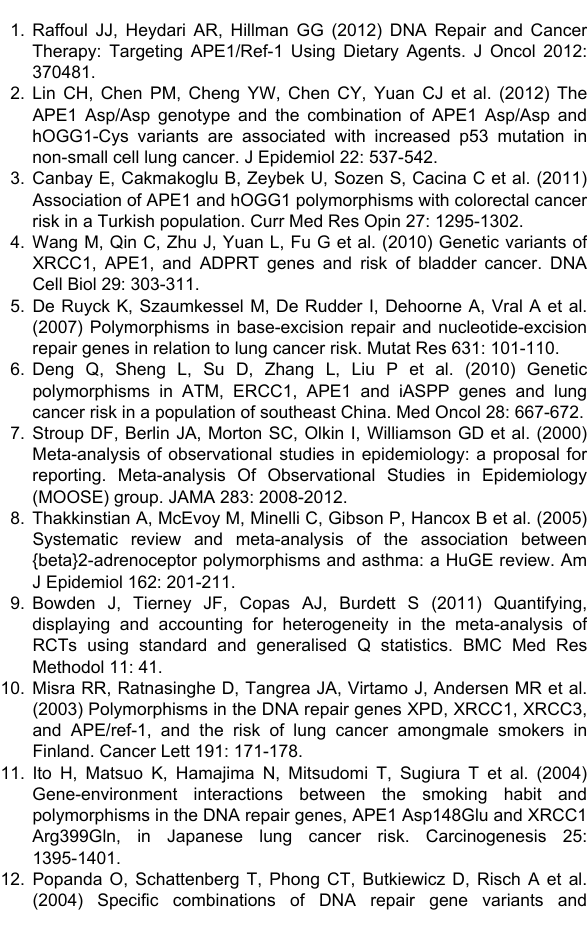
Figure S4. Forest plots of the small studies (the upper panel), and large studies (the lower panel) in subgroup analyses by sample size for the APEX1 Asp148Glu polymorphism under the allelic model. Figure S5. Forest plots of the high-quality studies (the upper panel), and low-quality studies (the lower panel) in subgroup analyses by sample size for the APEX1 Asp148Glu polymorphism under the allelic